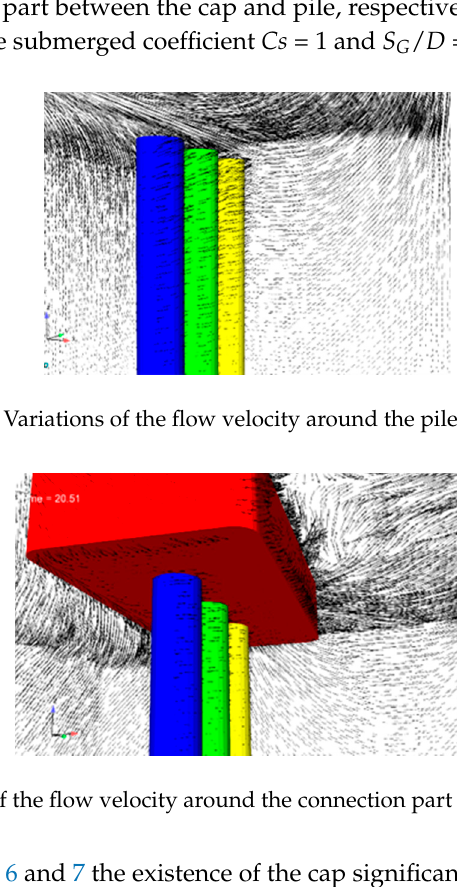
Table 1. Input parameters of numerical examples. Structural Characteristics Pile diameter (m)